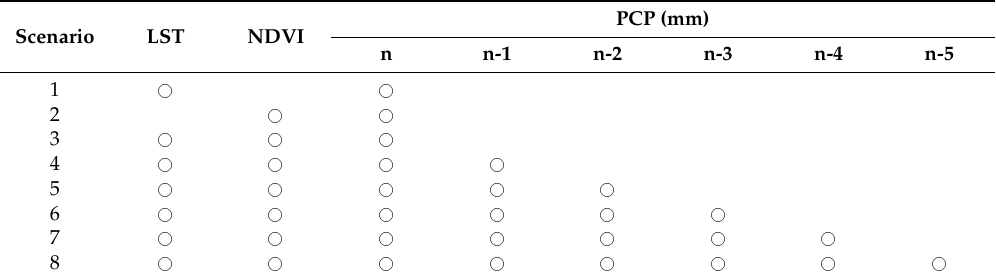
Table 3. Eight regression scenarios for MLR model using MODIS LST, MODIS NDVI, precipitation of the observation day (PCP n ), one day antecedent precipitation (PCP n-1 ), two-day antecedent precipitation (PCP n-2 ), three-day antecedent precipitation (PCP n-3 ), four-day antecedent precipitation (PCP n-4 ), and five-day antecedent precipitation (PCP n-5